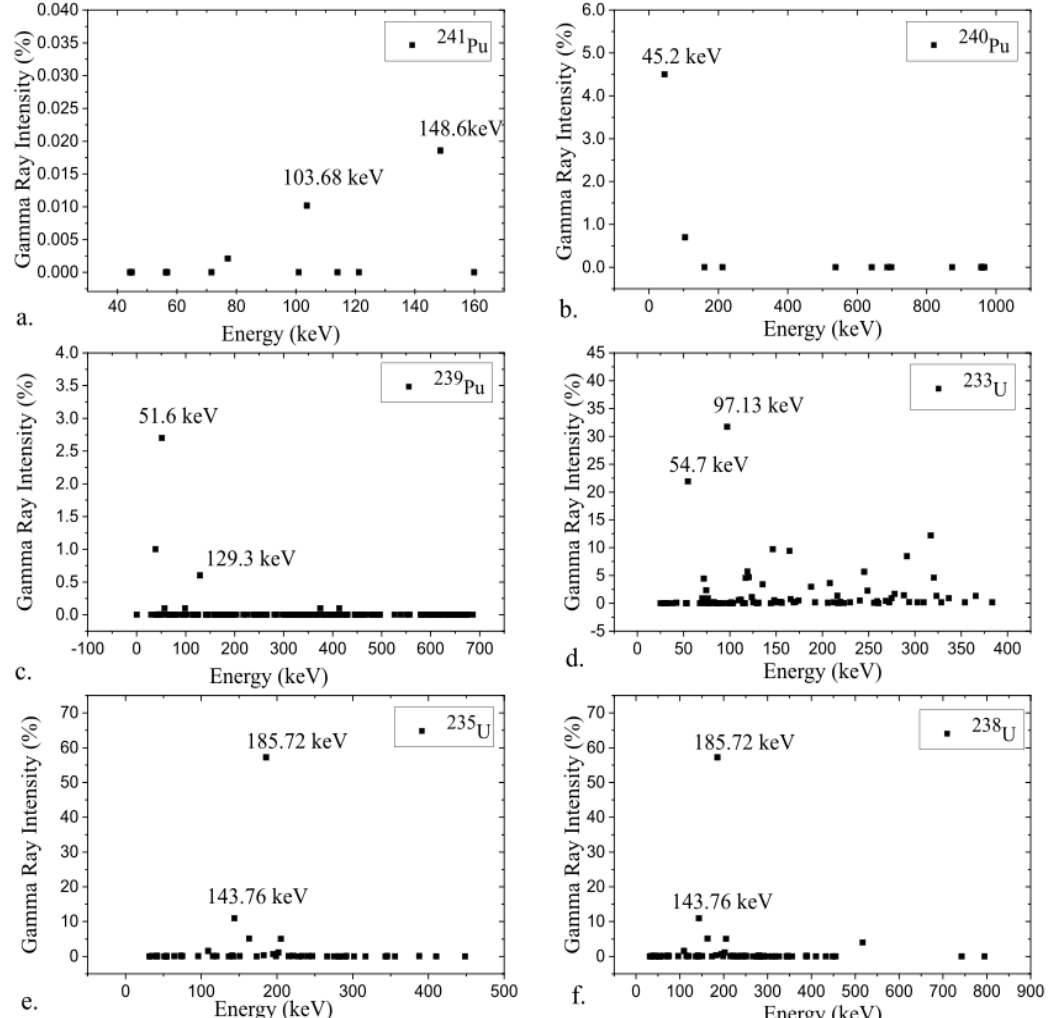
Figure 1. Characteristic gamma spectrum and gamma peaks of nuclear materials isotopes a. 241 Pu, b. 240 Pu, c. 239 Pu, d. 233 U, e. 235 U, f. 238 U (Data source: Idaho National Engineering and Environmental Laboratory [9]).